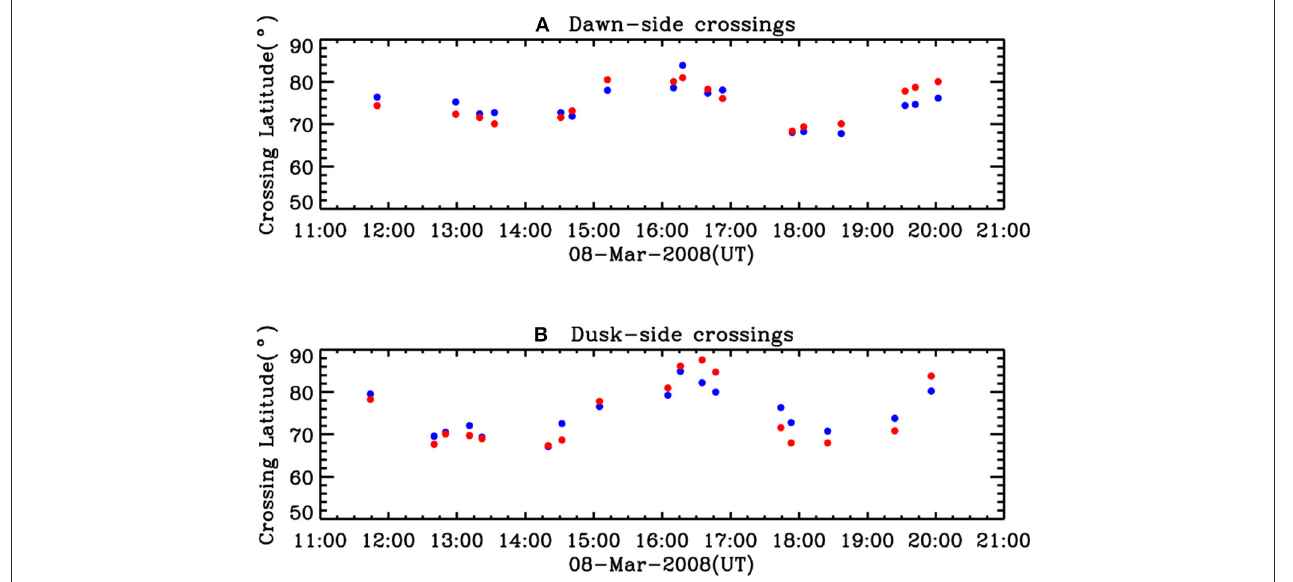
FIGURE 5 | The pattern of comparison of PCB latitudes between DMSP observations and PPMLR